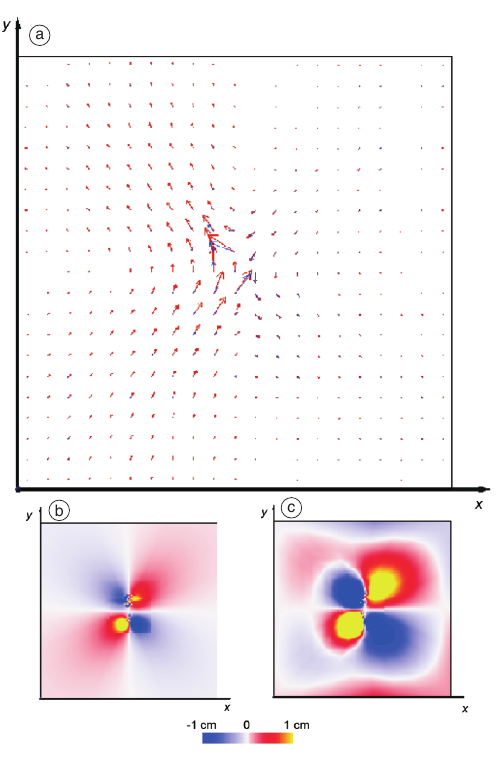
Fig. 20a-c. Ground coseismic and postseismic dis- placement field for a right-lateral strike slip with dip δ = 90° and strike φ = 0° embedded in the hetero- geneous plane domain illustrated in fig. 19. Horizontal displacement field: a) coseismic (blue arrows) and postseismic after 100 years (red arrows) are displayed simultaneously as a vector plot. Vertical displacement field: b) coseismic and c) postseismic after 100 years are displayed as color plots.